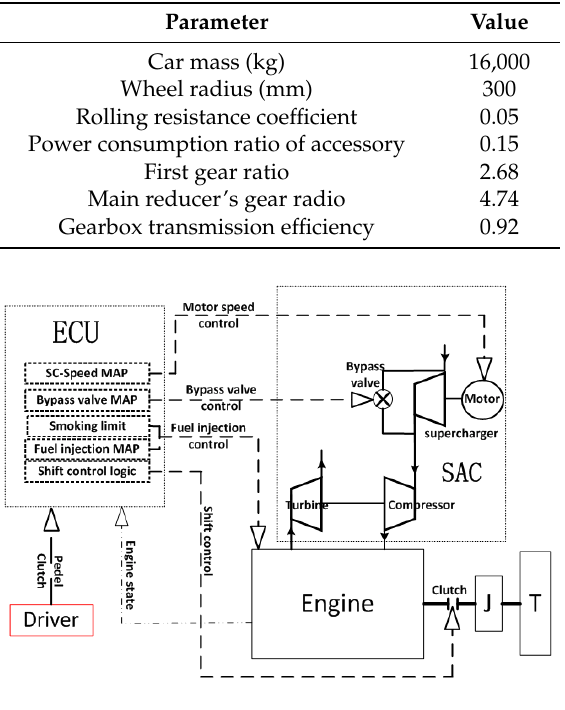
Figure 11. Vehicle simulation model.